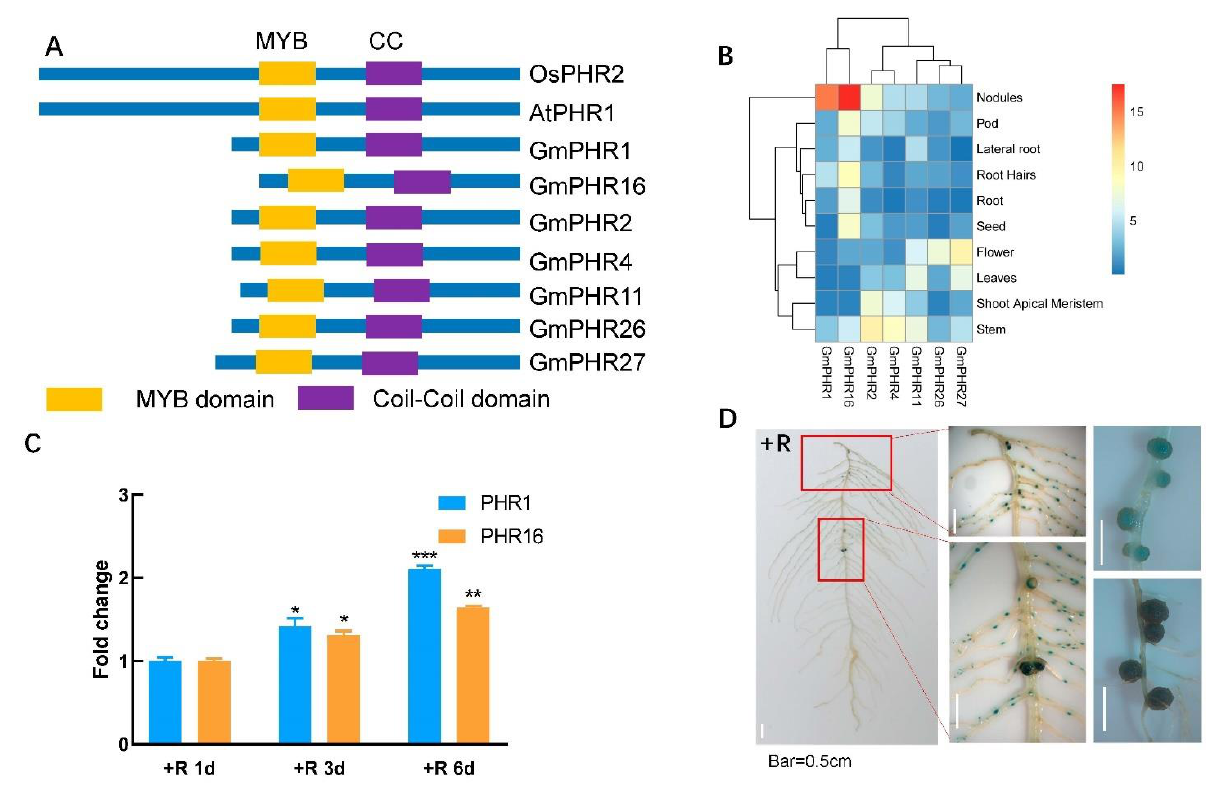
Figure 1. GmPHR1 and GmPHR16 were highly expressed in nodules and induced by rhizobium infection. ( A ). Schematic diagram of canonical and non-canonical PHRs with the position of MYB and coiled-coil domains marked in the proteins. ( B ). Expression levels of non-canonical GmPHRs in different tissues of soybean plants were compared using data downloaded from the Phytozome database (https://phytozome-next.jgi.doe.gov/pz/ accessed on 1 September 2021). Expression levels of atypical GmPHRs presented in a heatmap. ( C ). Time course expression analysis of GmPHR1 and GmPHR16 inoculated with Bradyrhizobium elkanii BXYD3. ( D ). Positive soybean hairy roots carrying GmPHR1 pro-GUS vector were generated as described in the methods. Hairy roots were inoculated with Bradyrhizobium elkanii BXYD3 for one month. Tissue expression patterns were determined with GUS histochemical staining and visualized with stereoscopic microscopes. For ( C ), asterisks represent statistically significantly differences from respective controls in the Student’s t test (*: 0.01 < p ≤ 0.05, **: 0.001 < p ≤ 0.01, ***: p ≤ 0.001).